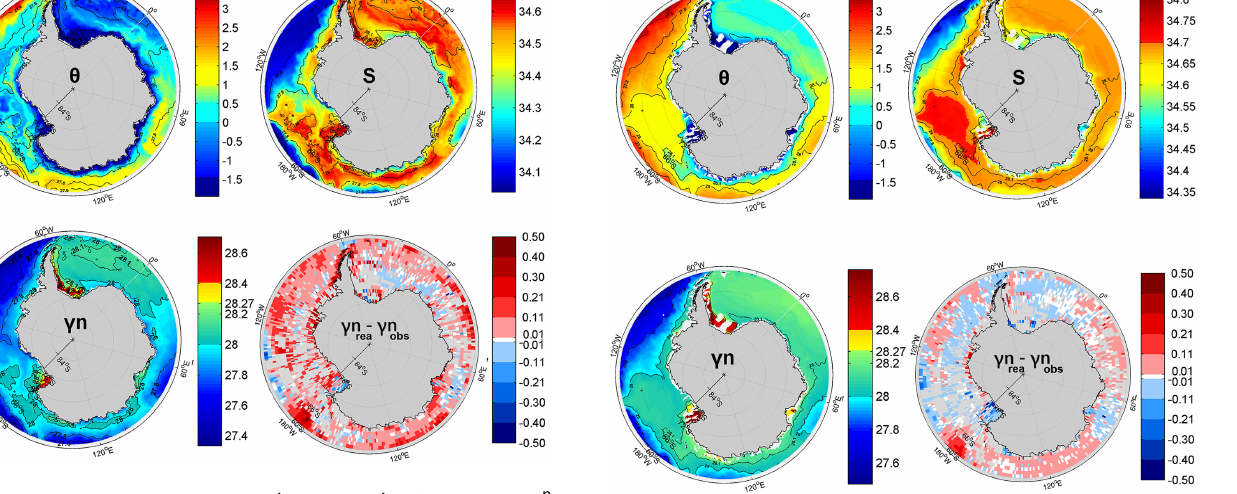
Figure 5. ECCO2 average fields (1992–2004) of θ , S , and γ n for the SL (100–150m). Black contours indicate isopycnals (units arekgm − 3 ) . The bottom right panel shows the difference between the reanalysis and observed density fields.